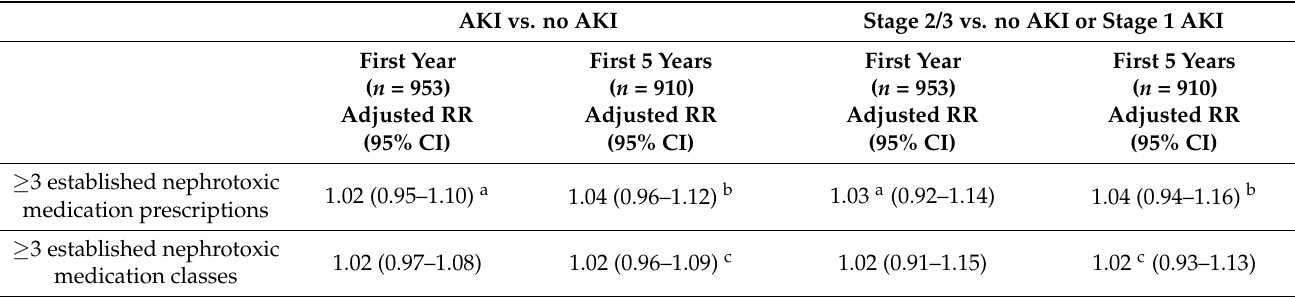
Table 1. Adjusted Association Between AKI and Administration of ≥ 3 Established Nephrotoxic Medication Prescriptions and Classes. AKI vs. no AKI Stage 2/3 vs. no AKI or Stage 1